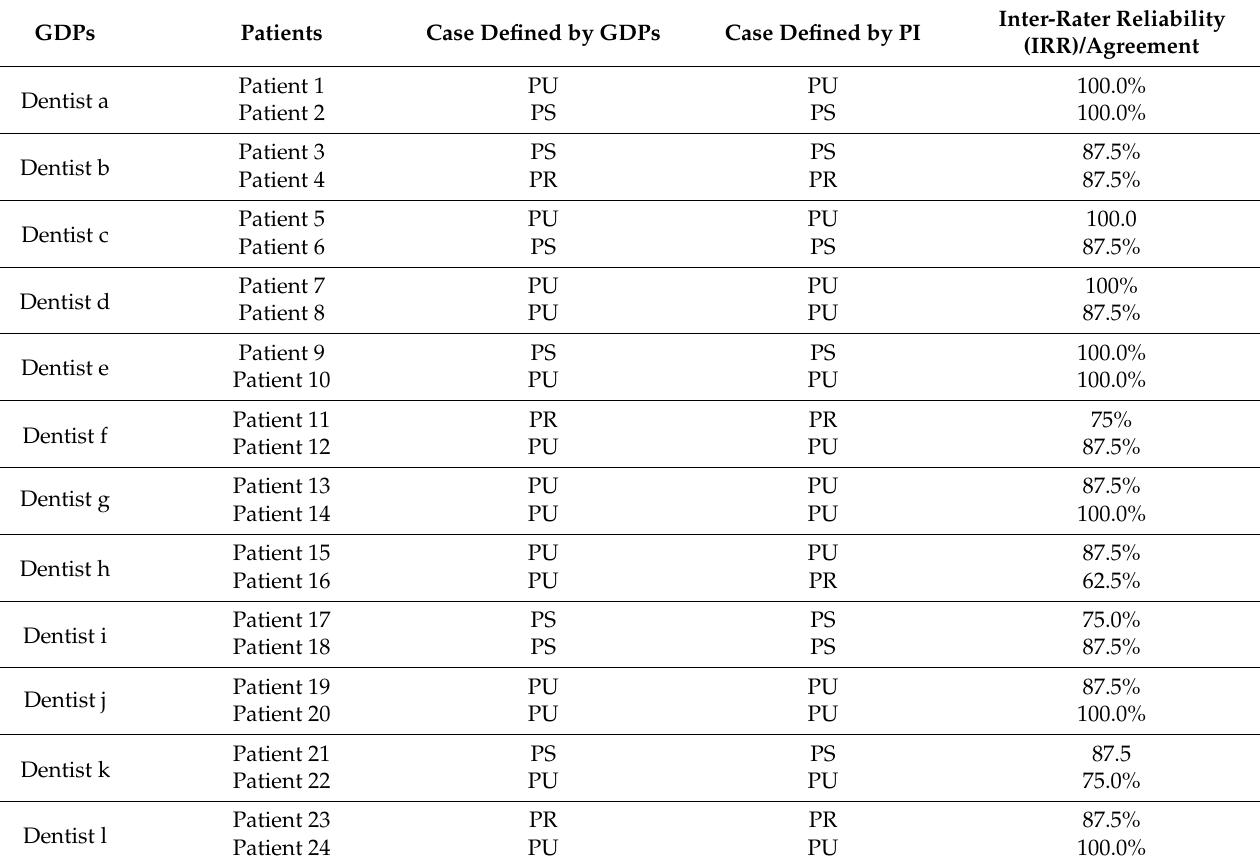
Table 5. Inter Rate Reliability (IRR) of Periodontitis Case Definition between the study participants and the principal investigator using the newly developed